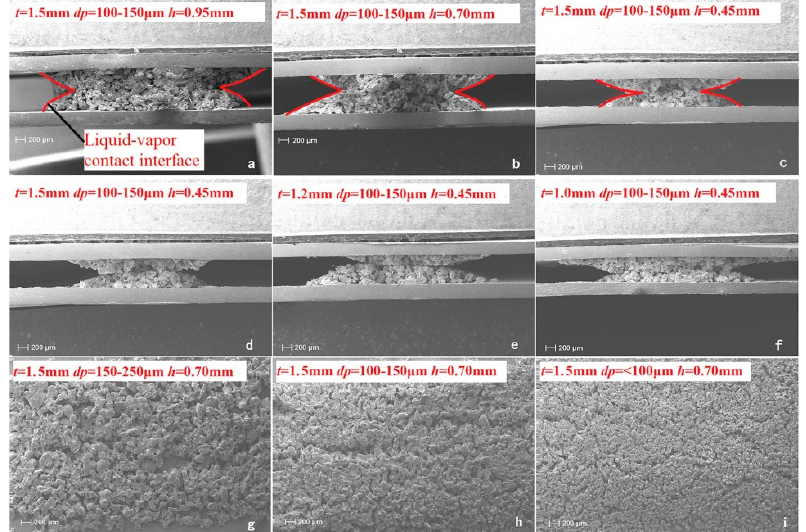
Figure 6. (a–i) SEM photographs of the wick structure with different parameters: t is the heat pipe squash thickness, dp is the copper powder particle size, and h is the maximum thickness of the absorbent wick [48].